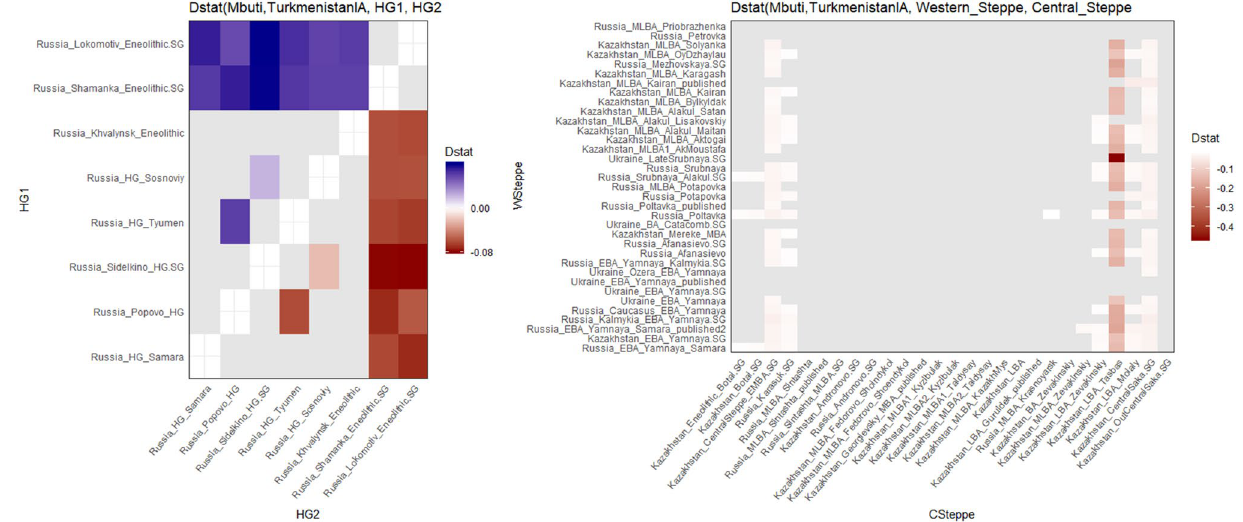
Figure 4. Absence of affinity of Turkmenistan_IA with East Asia ancestry shown by D-stat. In grey are non- significative (Z < 3) D-statistics, in blue significative positive D-statistics and in red significative negative one. Only populations with strong East Asian or BHG ancestry show a significative D-statistic. (Figure done with ggplot2 v. 3.3.3 R package https:// cran.r- proje ct. org/ web/ packa ges/ ggplo t2/ index.